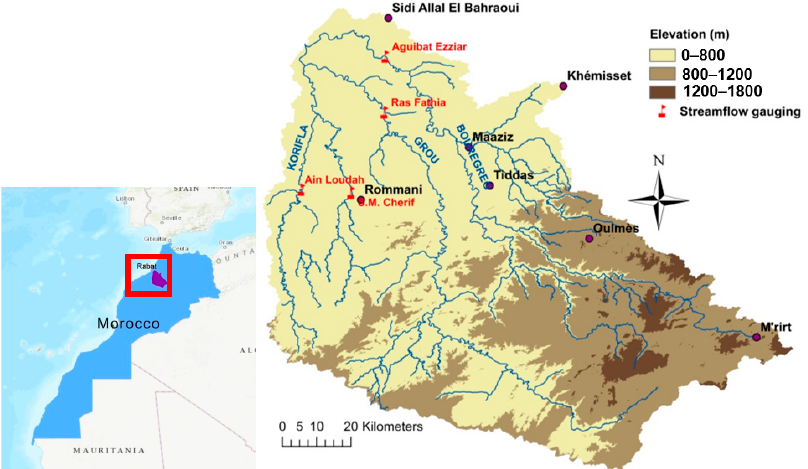
Figure 1. Location, topography and streamflow network of BW and the used gauging stations.